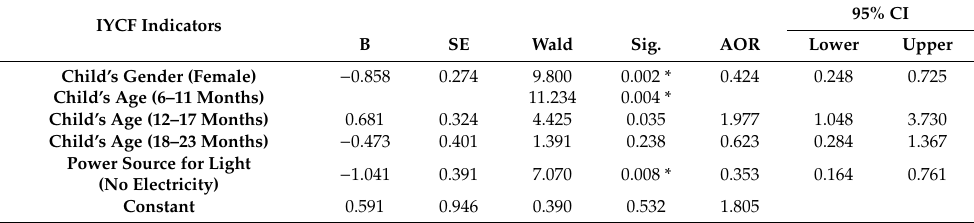
Table 7. Multivariable binary logistic regression analysis of predictors of